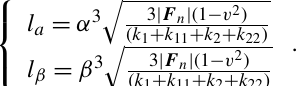
Tooth number of the driving gear Z 1 8 Tooth number of the driven gear Z 2 16 Radius of section circular of the driving gear surface R 1 5mm Radius of section circular of the driven gear surface R 2